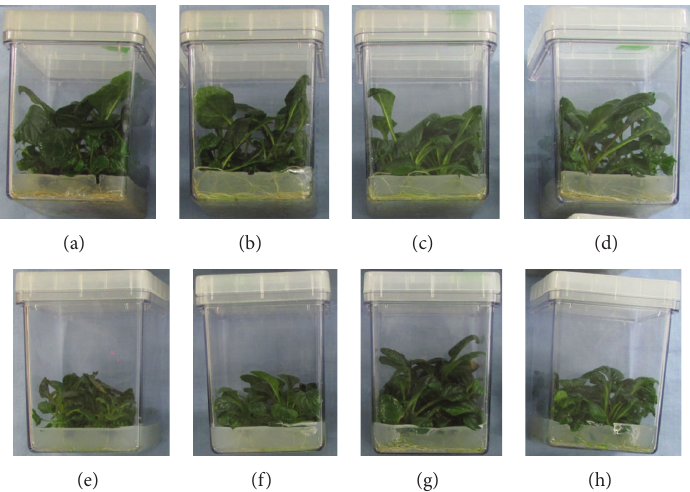
Figure 3: Effect of silicon and NaCl on shoot growth and rooting of A. multiflora . (a) MS medium, (b) MS + 1.8 mM Si, (c) MS + 3.6 mM Si, (d) MS + 7.2 mM Si, (e) MS + 50mM NaCl, (f) MS + 50 mM NaCl + 1.8mM Si, (g) MS + 50 mM NaCl + 3.6 mM Si, and (h) MS + 50mM NaCl + 7.2 mM Si.